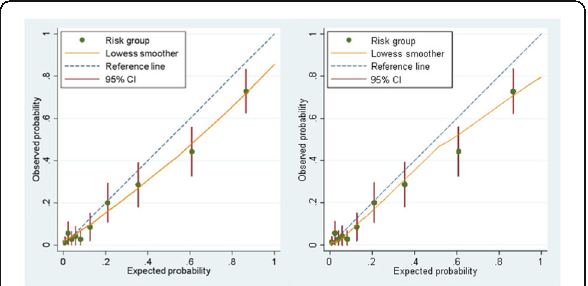
Fig. 1 (abstract P27). External validation calibration plots for the clinical features model (left) and clinical features + GAD model (right)